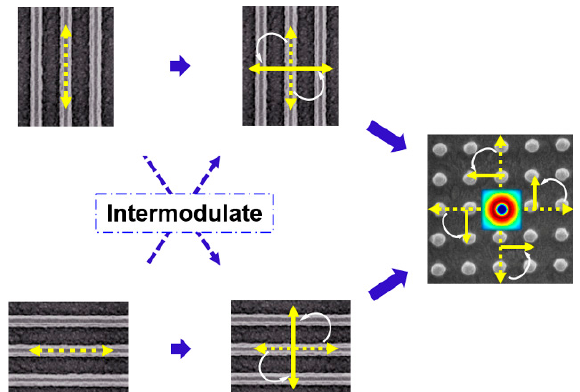
Figure 2. Schematic of the polarization intermodulation of laser modes in a 2D DFB cavity. The dotted double-arrow indicates the polarization of the DFB polymer laser. The solid double-arrow indicates the polarization of the DFB polymer laser after intermodulation. The white arrow denotes the rotation of the polarization.